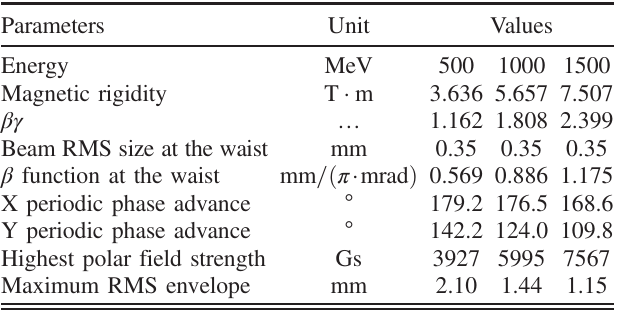
TABLE III. Parameters for different proton energies in VDS for n